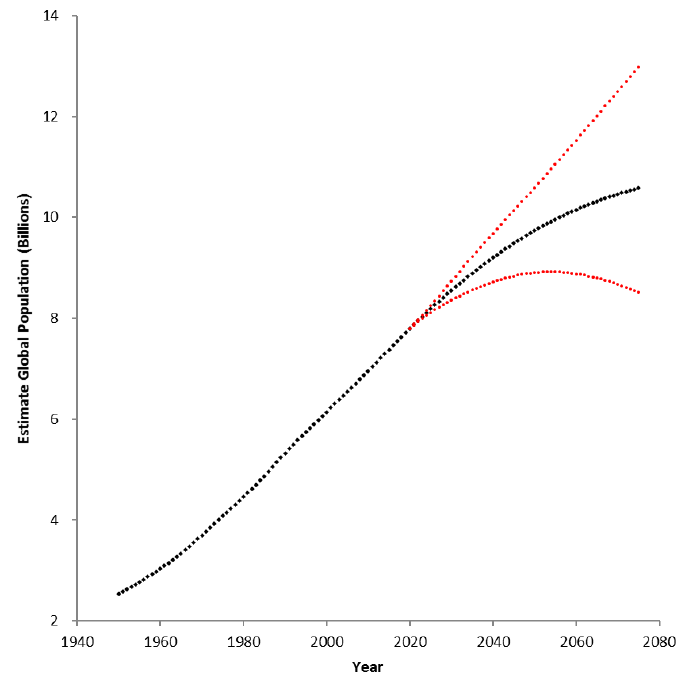
Figure 1. The world population is projected to reach nine billion by the mid-21st century. Data points up to 2020 are annual estimates. Black data points from 2021 to 2075 are estimates based on median fertility. Red data trends indicate high- and low-fertility variant estimates (raw data source: United Nations, Department of Economic and Social Affairs, Population Division (2019). World Population Prospects 2019, Online Edition. Rev. 1, accessed on 1 September 2021.